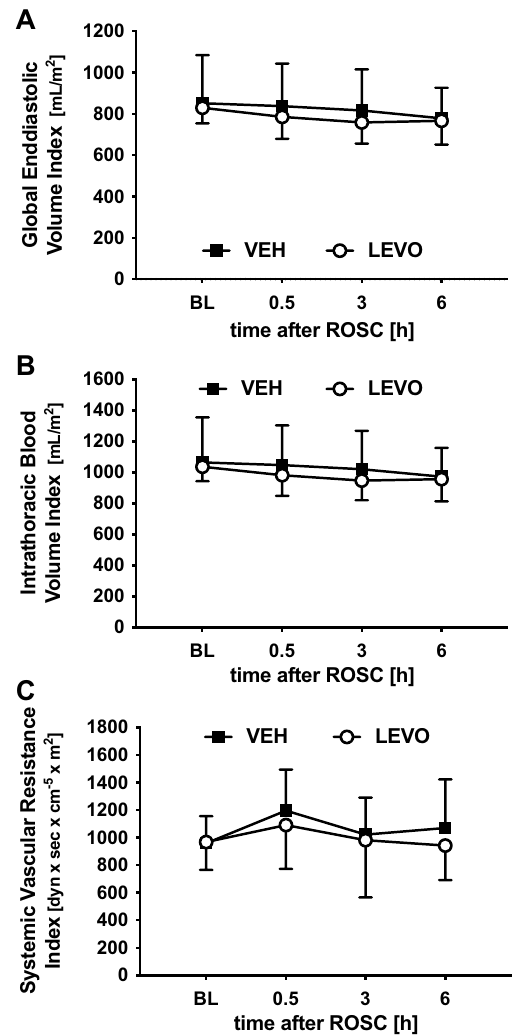
Figure 2. Surrogate parameters for cardiac preload and afterload. ( A ) Global end-diastolic volume index (GEDI) and ( B ) intrathoracic blood volume index as surrogate parameters for cardiac preload were determined using the PiCCO System before and 0.5, 3, and 6 h after ROSC to investigate changes in diastolic volume filling and diastolic function after cardiac arrest (CA) and levosimendan treatment. ( C ) To determine the influence on cardiac afterload, systemic vascular resistance index (SVRI) was recorded. CA and levosimendan did not influence any parameter at the selected time points. BL baseline, VEH vehicle, LEVO levosimendan. Statistics: repeated measures two-way ANOVA, followed by Šidák’s multiple comparisons test; data are presented as means ±